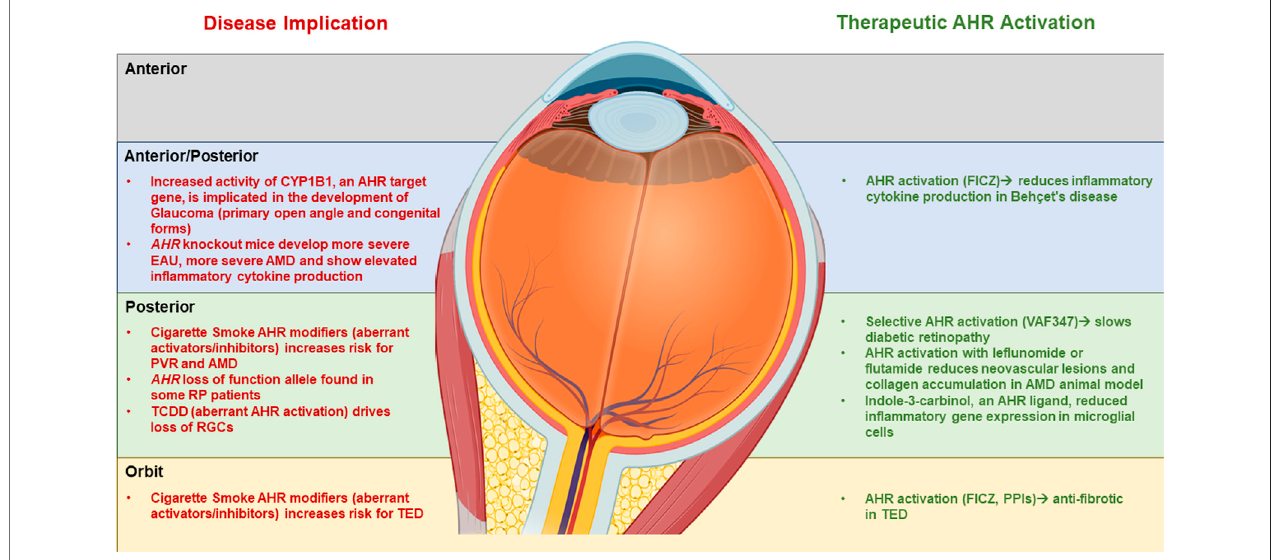
FIGURE 3 | Summary of the role of AHR in eye disease and the therapeutic potential of AHR activation AHR. A summary of the role of AHR in development of eye disease (left side) as compartmentalized into Anterior, posterior and orbital sections of the ocular system. On the right side is a summary of the potential use of AHR ligands in treating ocular